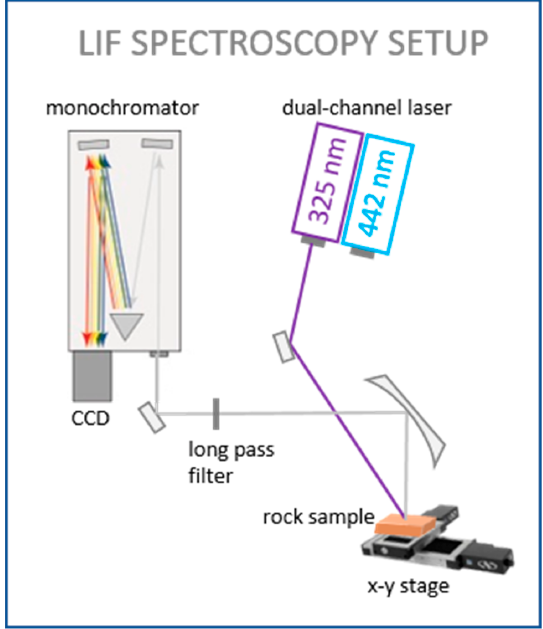
Figure 2. Sketch of setup used for laser-induced fluorescence (LIF) spectroscopy experiments, including laser excitation source, sample on an x-y-stage, monochromator, and a charge-coupled device (CCD) detector.